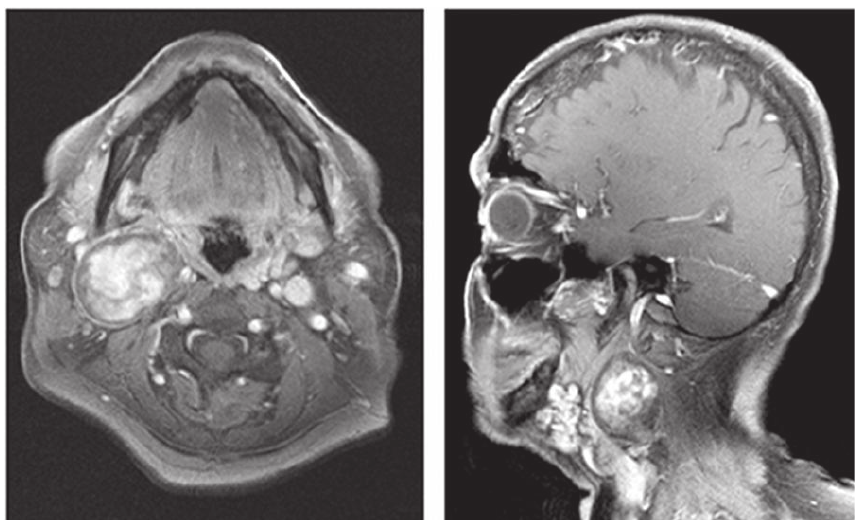
Figure 1: Postcontrast MRI of the neck demonstrating a mass at the level of the carotid bifurcation.